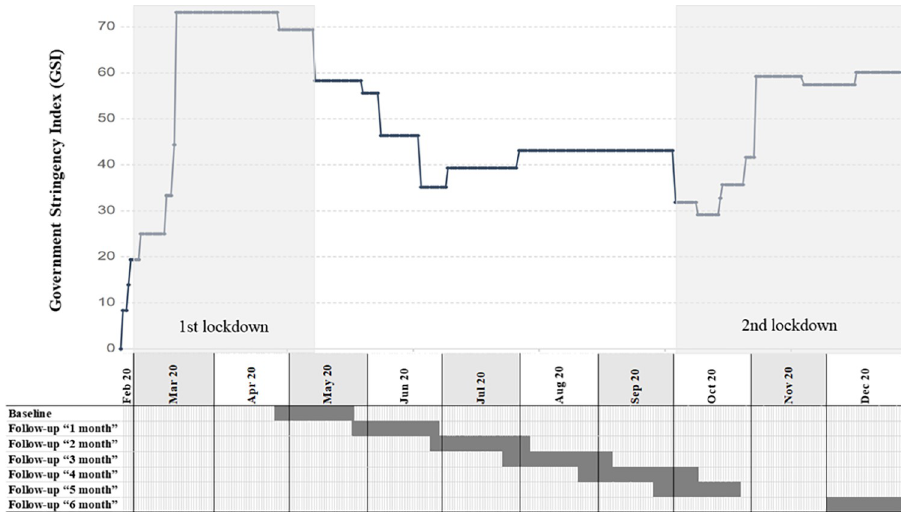
Fig 1. Study timeline. 1 st lockdown: 1 st March until 10 th May 2020; 2 nd lockdown: started on the 2 nd October 2020 and did not end within the 6-month follow-up period of this study; First survey during lockdown: 25 th April until 26 th May 2020; Follow-up 1-month: 26 th May until 29 th June 2020; Follow-up 2-month: 26 th June until 04 th August 2020; Follow-up 3-month: 25 th July until 6 th September 2020; Follow-up 4-month: 24th August until 10th October 2020; Follow-up 5-month: 23 rd September until 27 th October 2020; Follow-up 6-month: 01 st December 2020 until 04